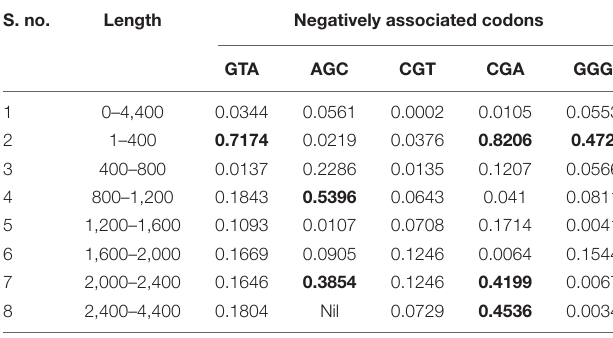
TABLE 1 | Regression coefficients (GC3 vs. RSCU) of codons that were significantly associated with transcript length. Codons positively associated with length